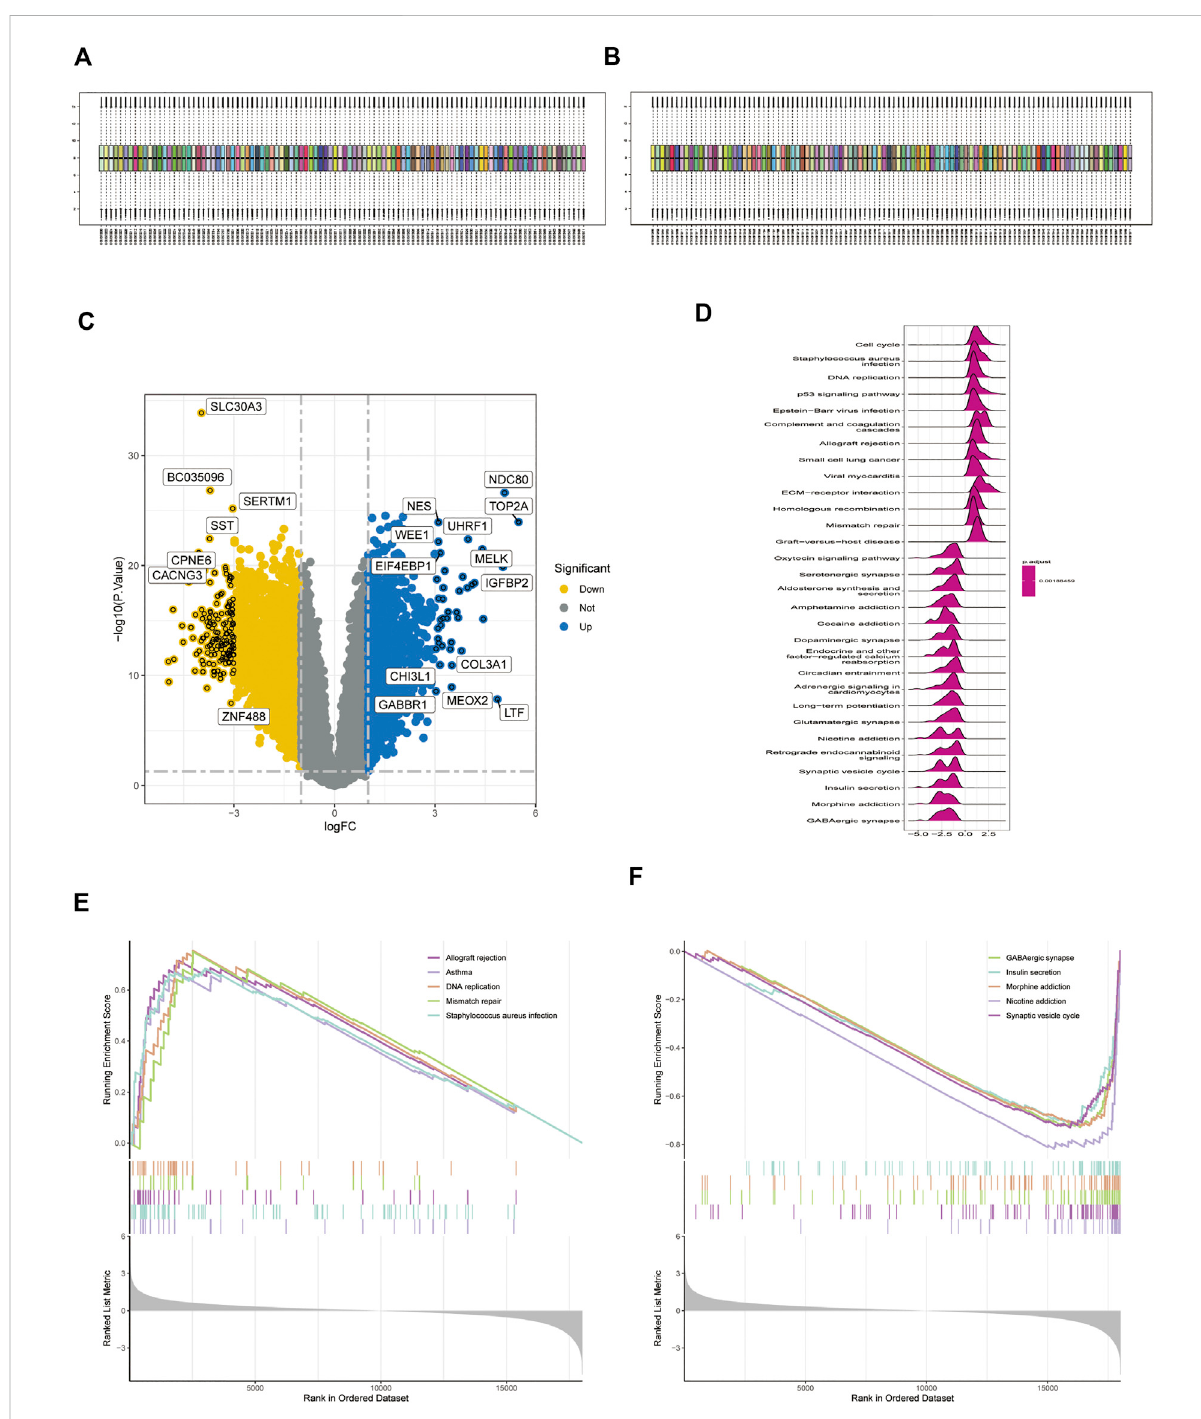
FIGURE 3 Expression of differentially expressed genes (DEGs) in the GSE4290 dataset. (A,B) Datasets were compared before and after normalization. (C) VolcanoplotofDEGsintheGSE4290dataset. (D) RidgeplotswithnormalizedenrichmentscoresshowthepathwayswhereDEGsaremostenriched in gene set enrichment analysis (GSEA). (E,F) GSEA analysis based on KEGG